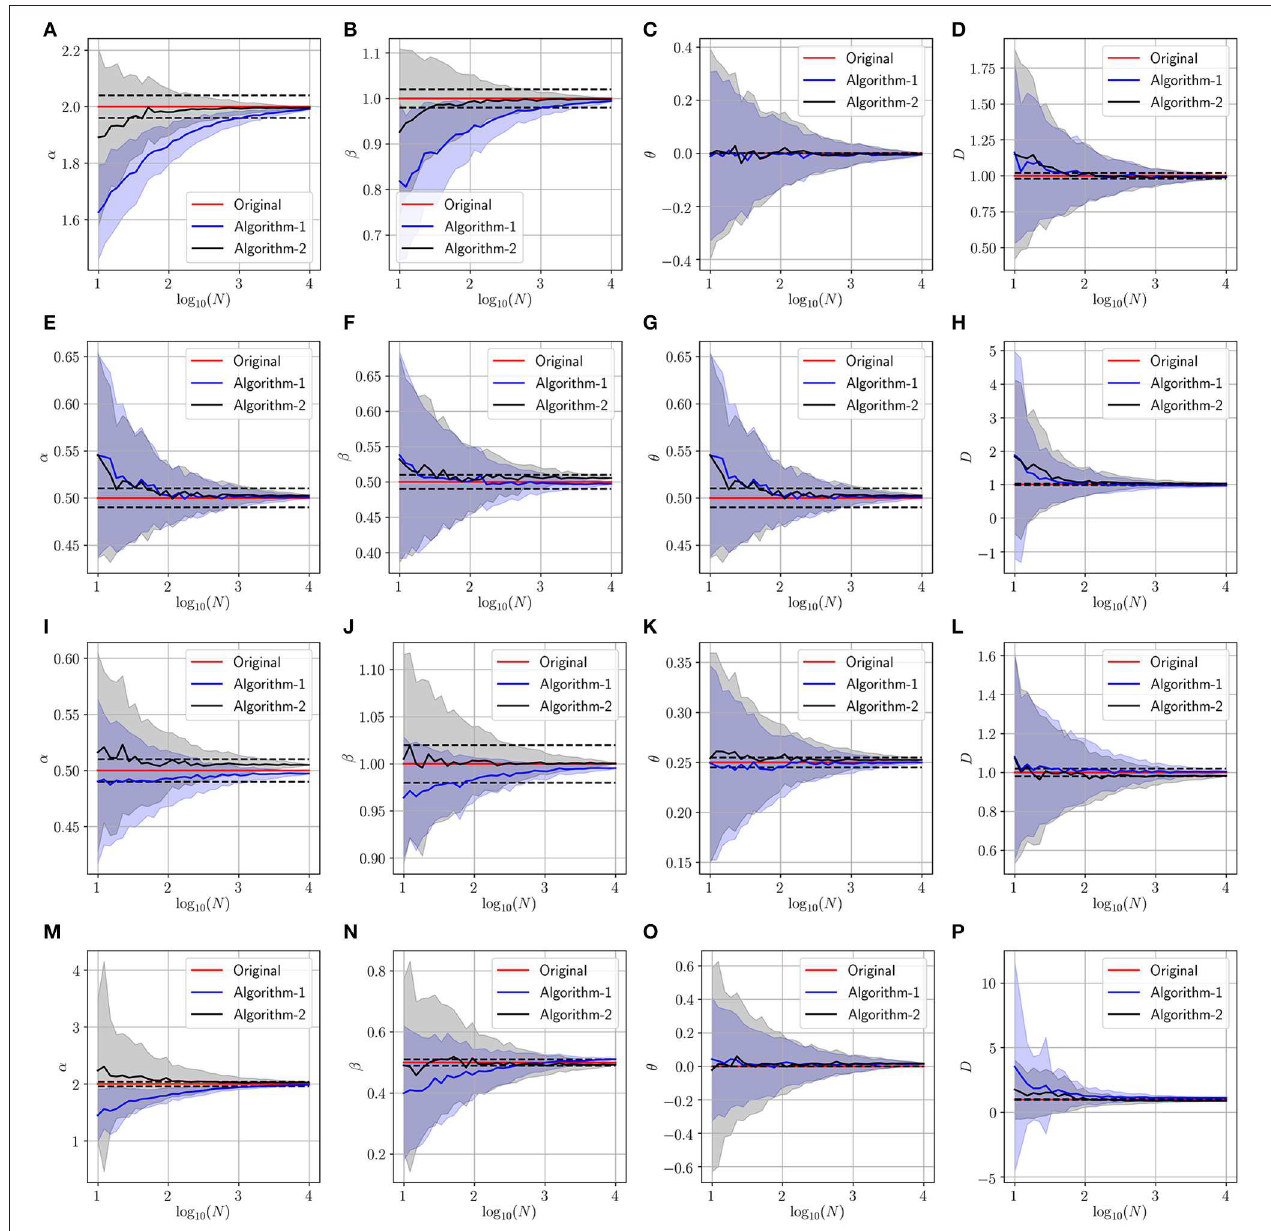
FIGURE 3 | Determining the parameters of the space-time fractional diffusion via the two proposed algorithms while varying the number of trajectories and the generalized diffusion coefficient D 1. The dotted line indicate 2 % error tube around the original parameter value in the red: (A–D) Normal diffusion equation = ( α 2, β 1, θ 0), (E–H) Neutral diffusion equation ( α 0.5, β 0.5, θ 0.5), (I–L) Space fractional diffusion equation ( α = = = = = = fractional diffusion equation ( α 2, β 0.5, θ = = =